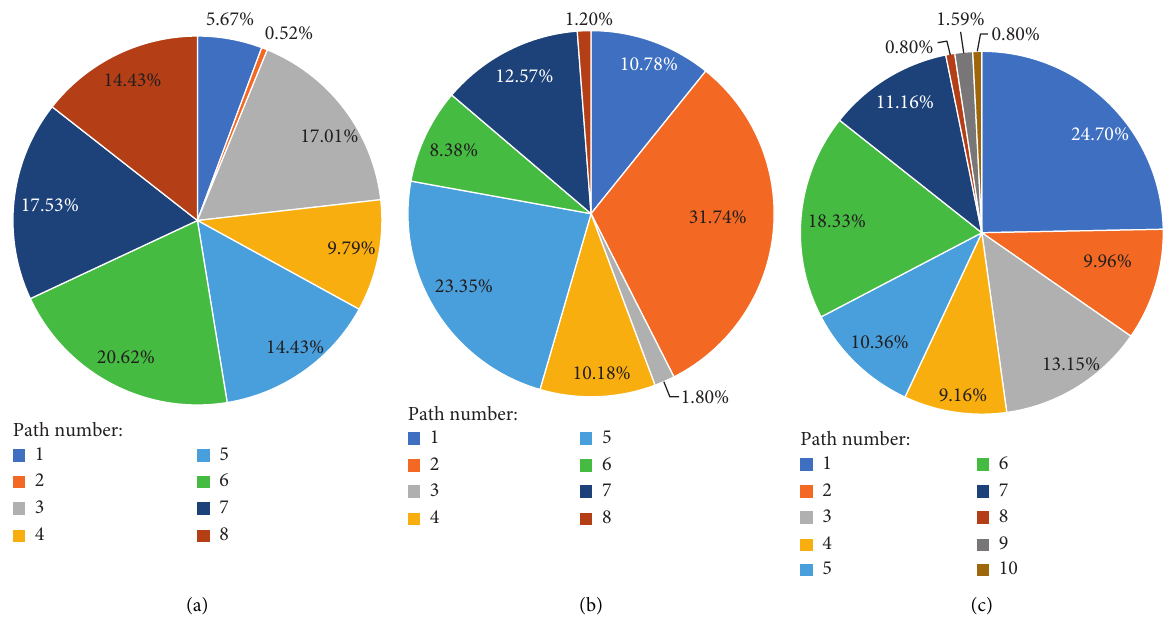
Figure 8: Probability distribution of route choice for different route categories: (a) short distance, (b) medium distance, and (c) long distance.